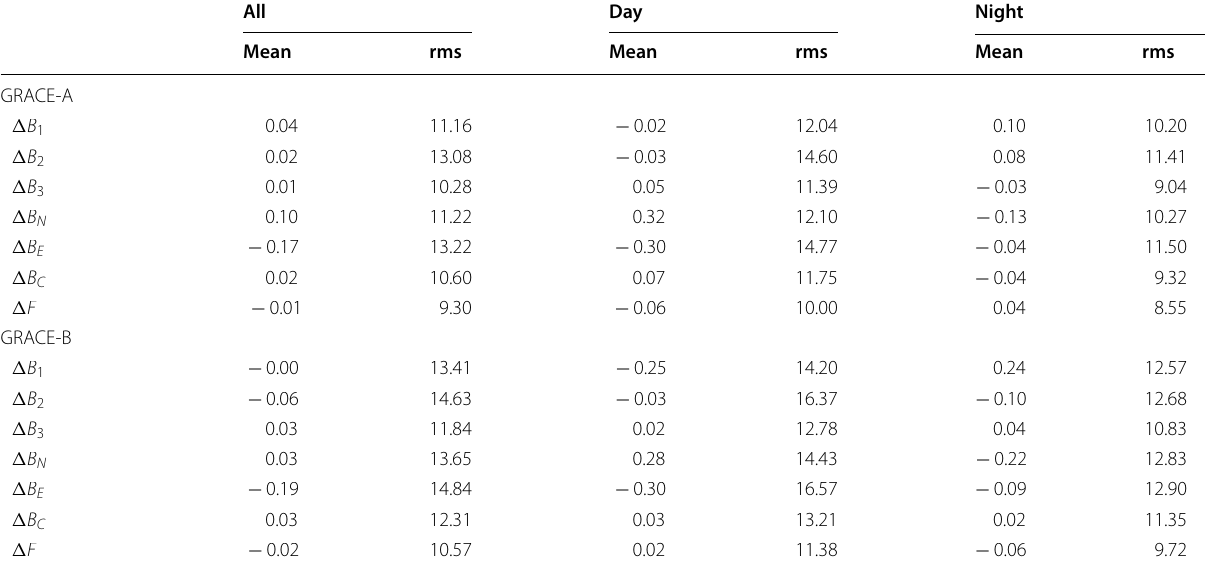
Table 1 Huber-weighted mean and rms misfit (in nanotesla) for the various vector components, in the magnetometer frame ( B 1 , B 2 , B 3 ) and in the NEC frame ( B N , B E , B C ) All